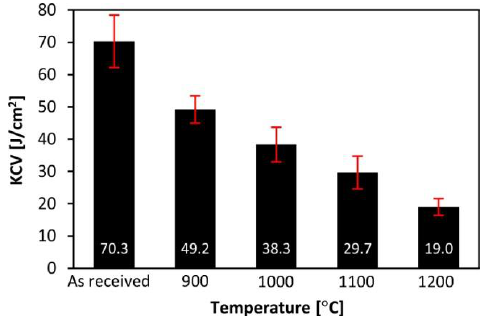
Figure 7. Impact strength KCV of tested steel in the as-received state and after different austenitizing